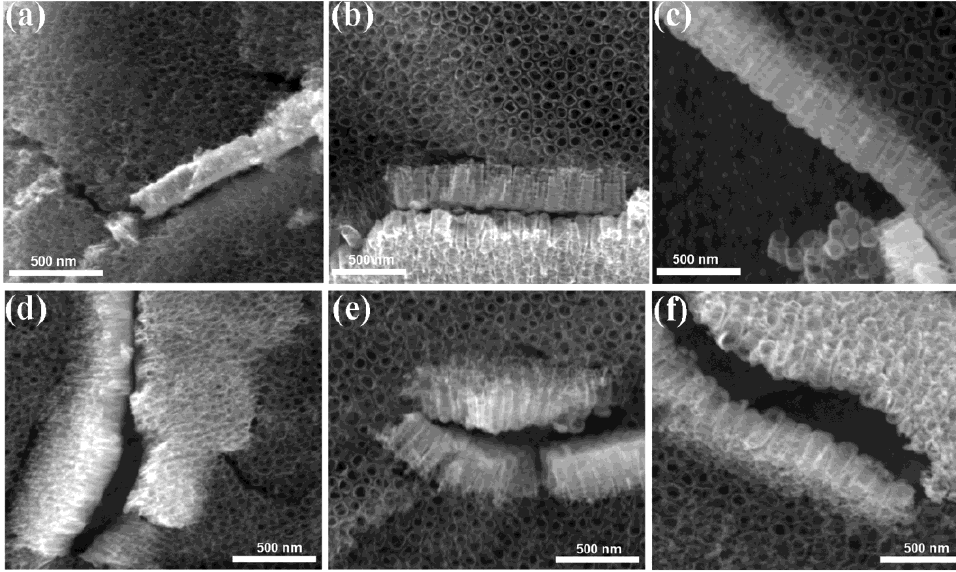
Figure 2. Cross-section of TiO 2 nanotube arrays for samples: ( a ) T-10, ( b )T-15, ( c )T-20 ( d ) TV-10, ( e ) TV-15, ( f ) TV-20.